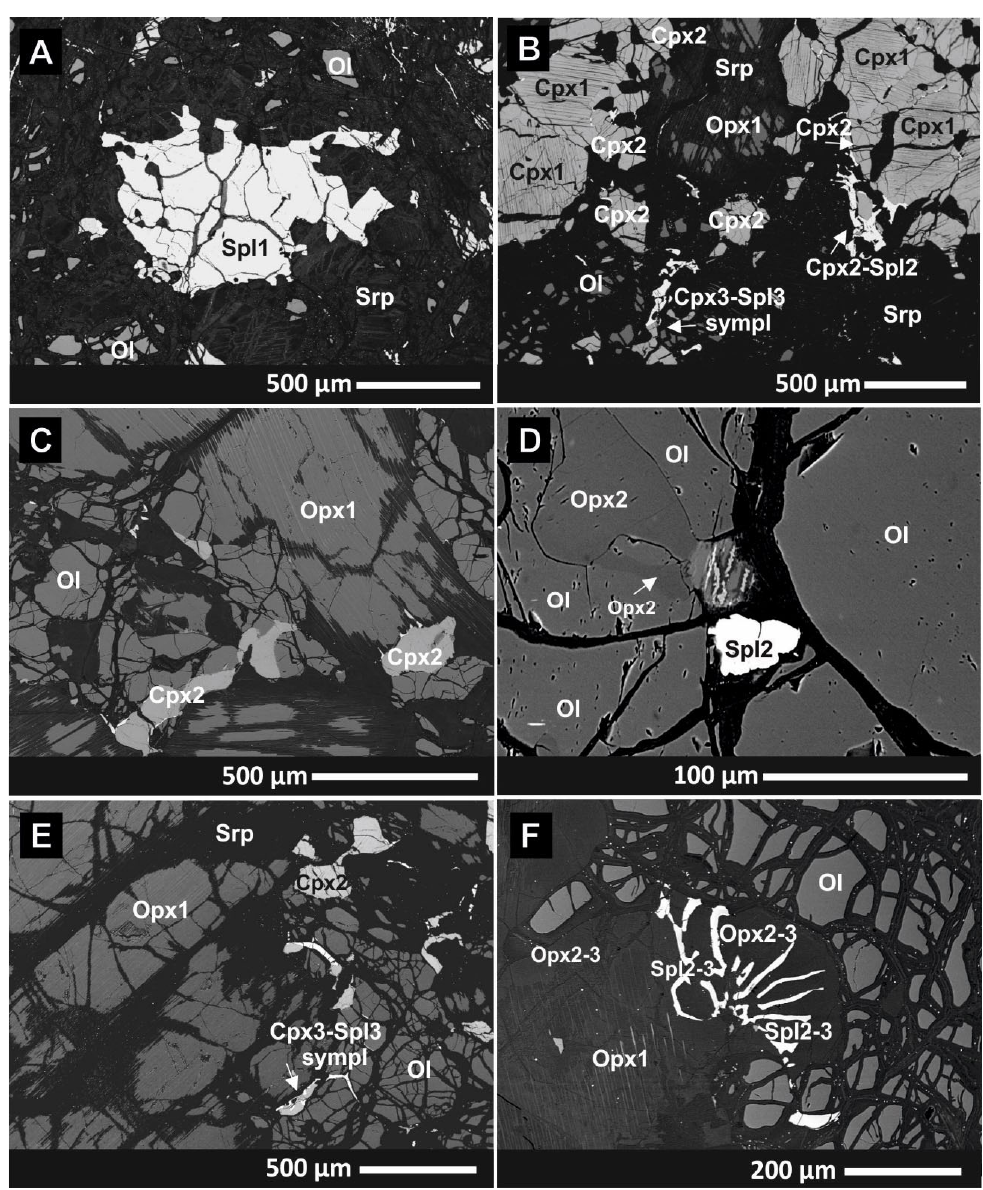
Figure 5. BSE images of lherzolites. ( A ) Spl1 in serpentinized Ol matrix (P2). ( B ) Cpx1 porphyroclastic aggregates with Opx exsolutions. Cpx1 has a rim of Cpx2 without exsolutions. Cpx2 ‐ Spl2 aggregates and Cpx3 ‐ Spl3 symplectites (P2). ( C,D ) Opx1 porphyroclasts with Cpx exsolutions. Opx2, Cpx2, and Spl2 aggregates follow Ol ‐ Opx1 and Ol ‐ Cpx1 boundaries (P2, P8). ( E ) Cpx3 ‐ Spl3 symplectites (P2) at Ol ‐ Opx1 boundary and in the Ol matrix. ( F ) Detailed view on Opx1 rim with Opx2 ‐ 3–Spl2 ‐ 3 symplectites (P2).